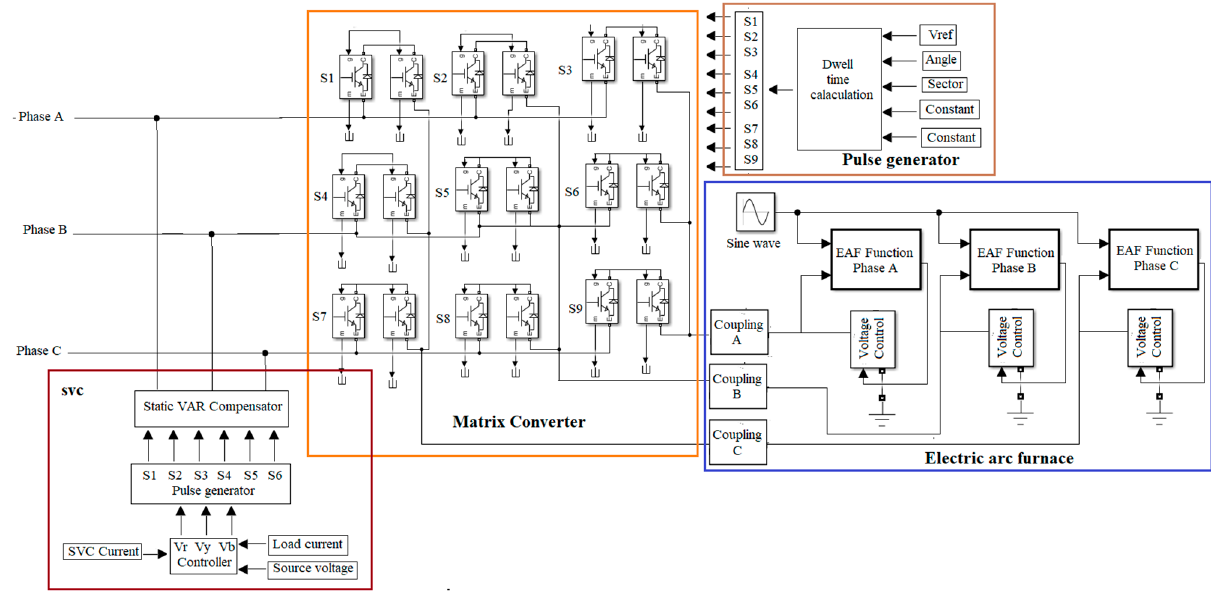
Figure 6. EAF model with DSP-based controller, MC, and SVC.